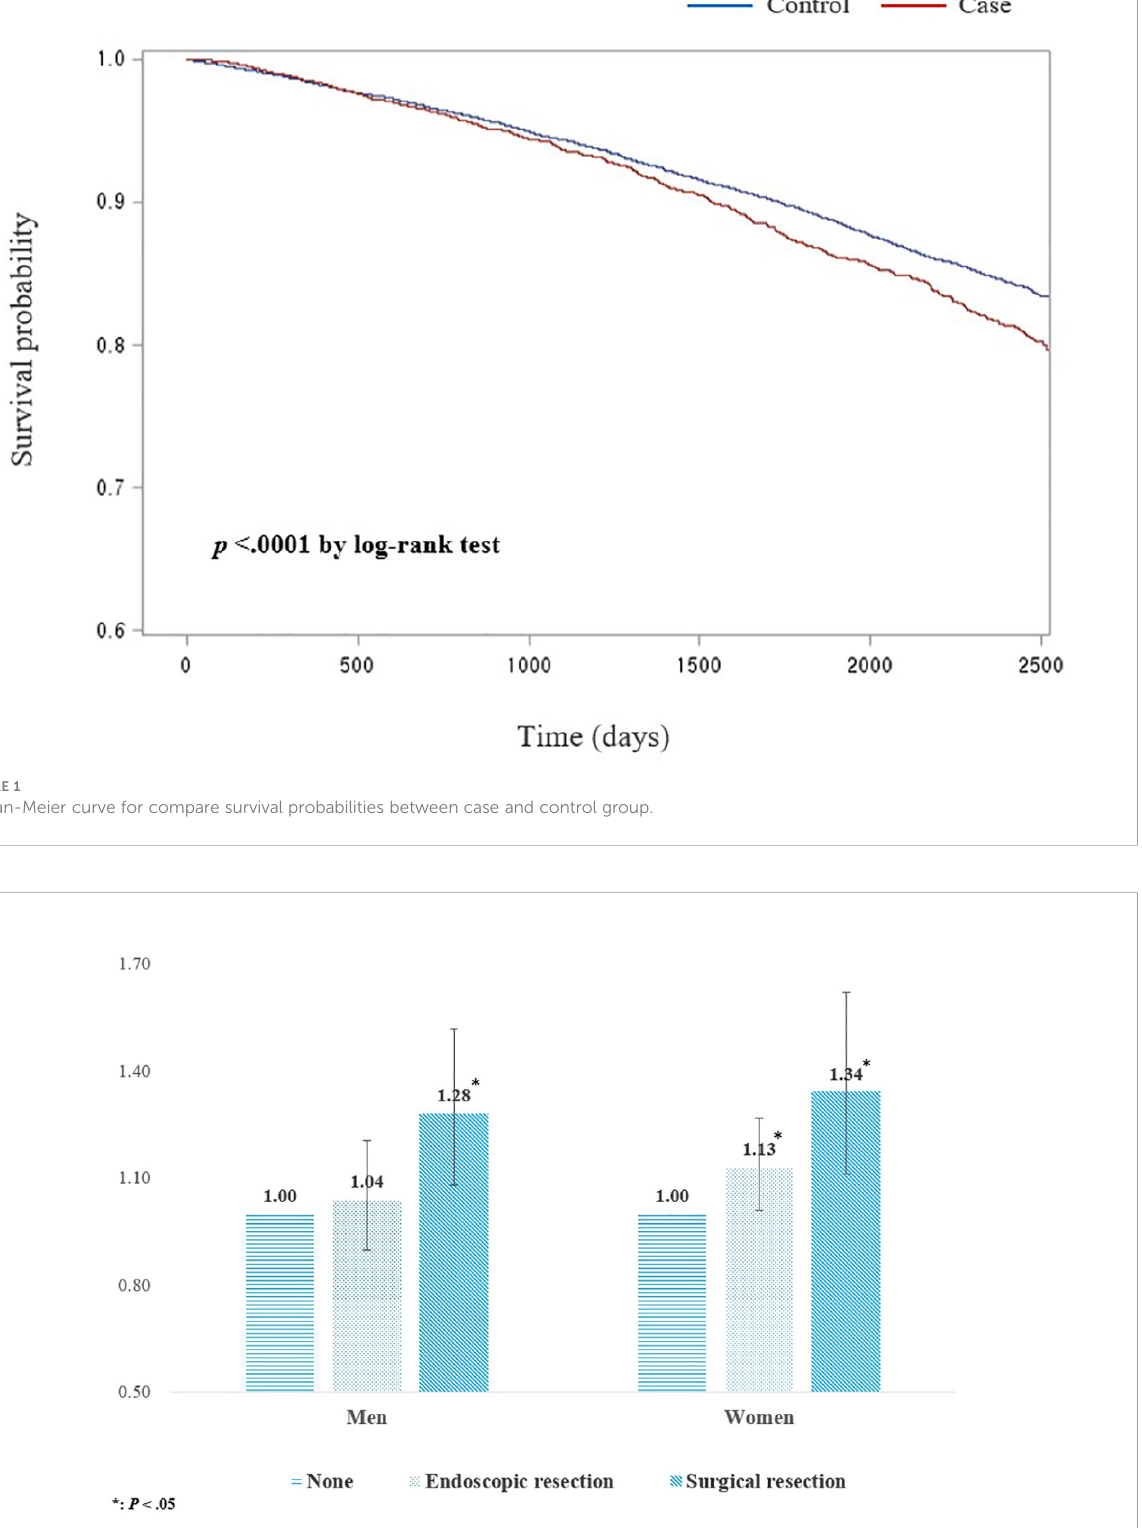
FIGURE 2 Results of subgroup analysis strati fi ed by gastrectomy